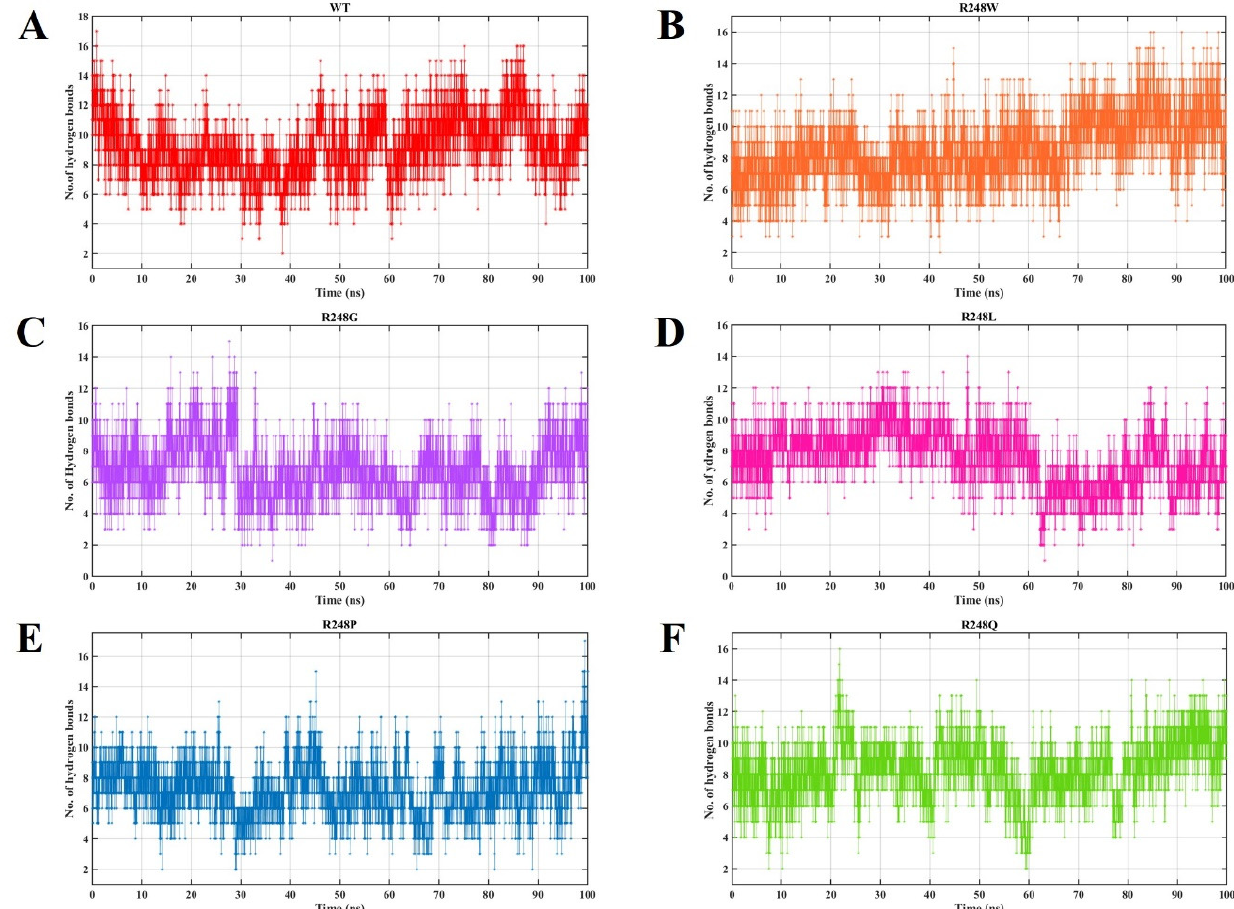
Figure 3. Number of H-bonds between the p53 protein and DNA in the wt-p53–DNA complex and R248 mutant-p53–DNA complexes. The X and Y axes denote time (ns) and the number of H-bonds. ( A ) The red color represents the wt-p53–DNA complex, ( B ) the orange color represents the R248W mutant-p53–DNA complex, ( C ) the violet color represents the mutant R248G mutant-p53–DNA complex, ( D ) the pink color represents the mutant R248L mutant-p53–DNA complex, ( E ) the blue color represents the mutant R248P mutant-p53–DNA complex, and ( F ) the green color represents the mutant R248Q mutant-p53–DNA complex.